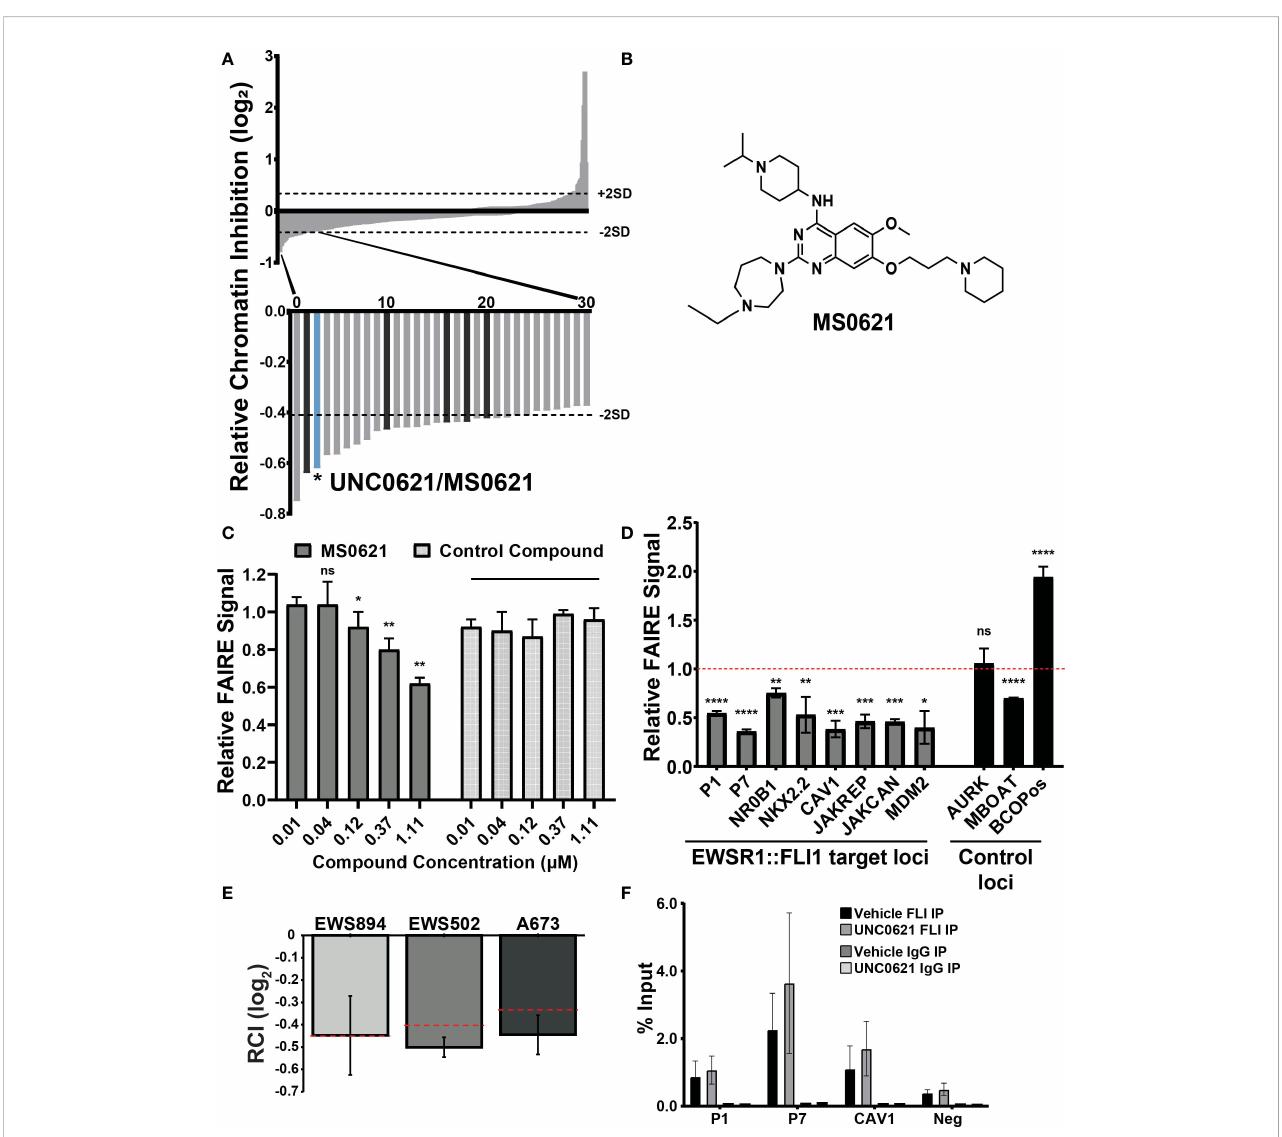
FIGURE 1 A chromatin-based screen identi fi es a small molecule modulator of chromatin state at EWS-FLI-bound GGAA microsatellites. (A) Waterfall plot of screen results with rank ordered Relative Chromatin Inhibition values (RCI, FAIRE signal at Ewing sarcoma regions/FAIRE at control regions, log2). Dashed lines indicate +/- 2SDs from the average RCI for vehicle controls. Magni fi cation: Thirty compounds demonstrating the greatest decrease in FAIRE signal. The bar representing UNC0621/MS0621 is indicated in light blue. Dark gray bars indicate structural analogs of MS0621 (discussed further in Figure 2). Figure adapted from (9). (B) Chemical structure of MS0621 (C) FAIRE-qPCR at the regions used in the screen in EWS894 cells treated with MS0621 or a control compound for 16 (h) Results are shown as a fraction of input control. Error bars represent the standard error of four biological replicates for MS0621